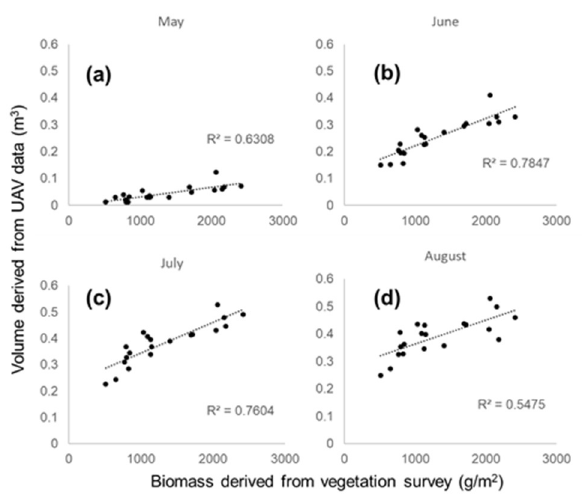
Figure 8. Comparison between volume of M. sinensis derived from UAV data: May (a), June (b), July (c) and August (d), and biomass derived from vegetation survey in